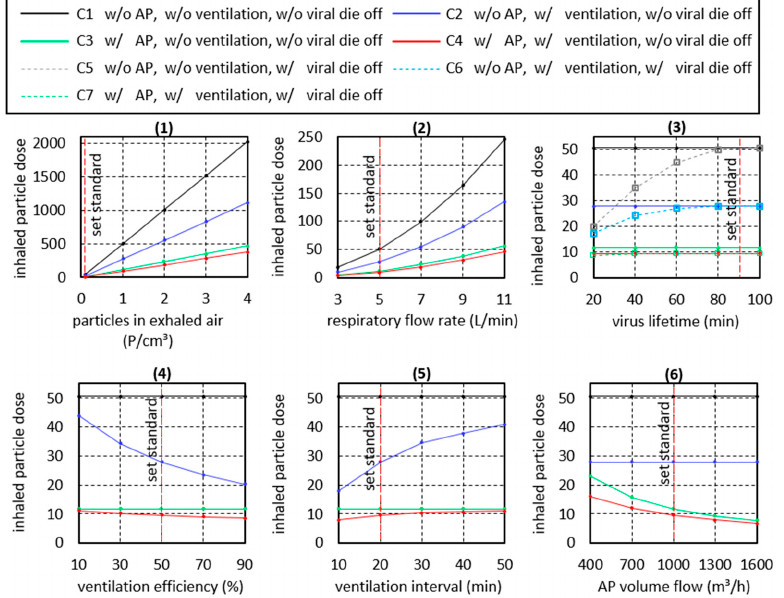
Figure 8. Effect diagrams of the influence parameters of Table 4. Except for the parameter that is varied in each case, the other influence parameters are kept at their set standard value in the individual diagrams. The following conditions are applied: room size 200 m 3 , AP volume flow 1000 m 3 /h, ventilation interval 20 min, ventilation duration 3 min, ventilation air exchange 50%, viral die-off after 90 min.